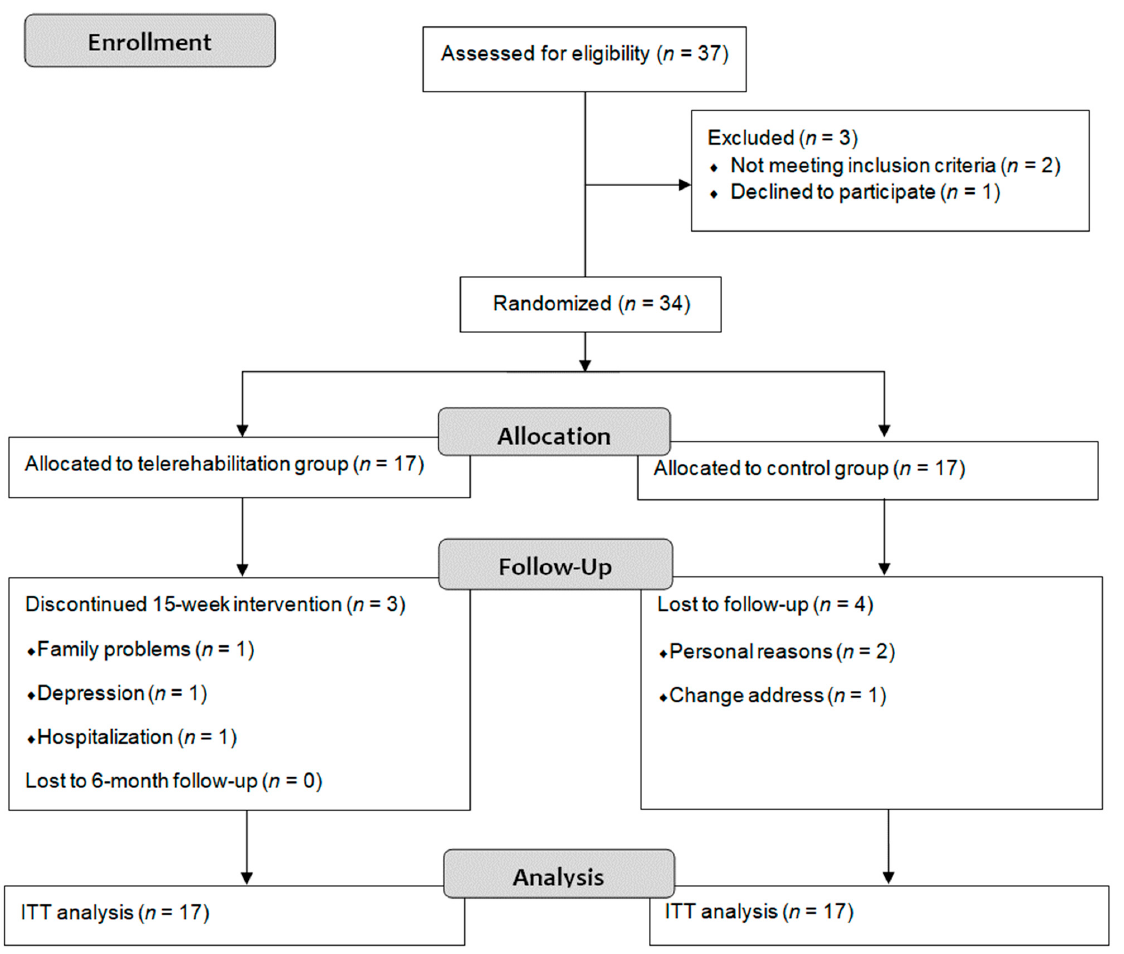
Figure 1. Flow diagram. ITT: intention-to-treat.